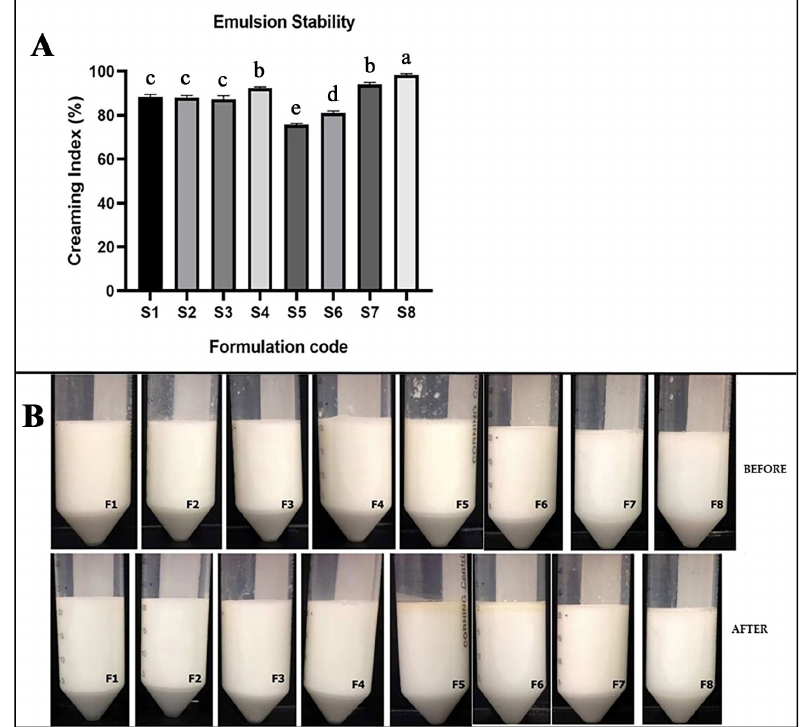
Figure 3. ( A ) The emulsion stability (Cl%, creaming index) of prepared emulsions (after 24 h). Data represent means ± SD, n = 6. Different letters in each column denote statistical difference at p ≤ 0.05. ( B ) Typical visual images of 8 emulsions after storage for 24 h .